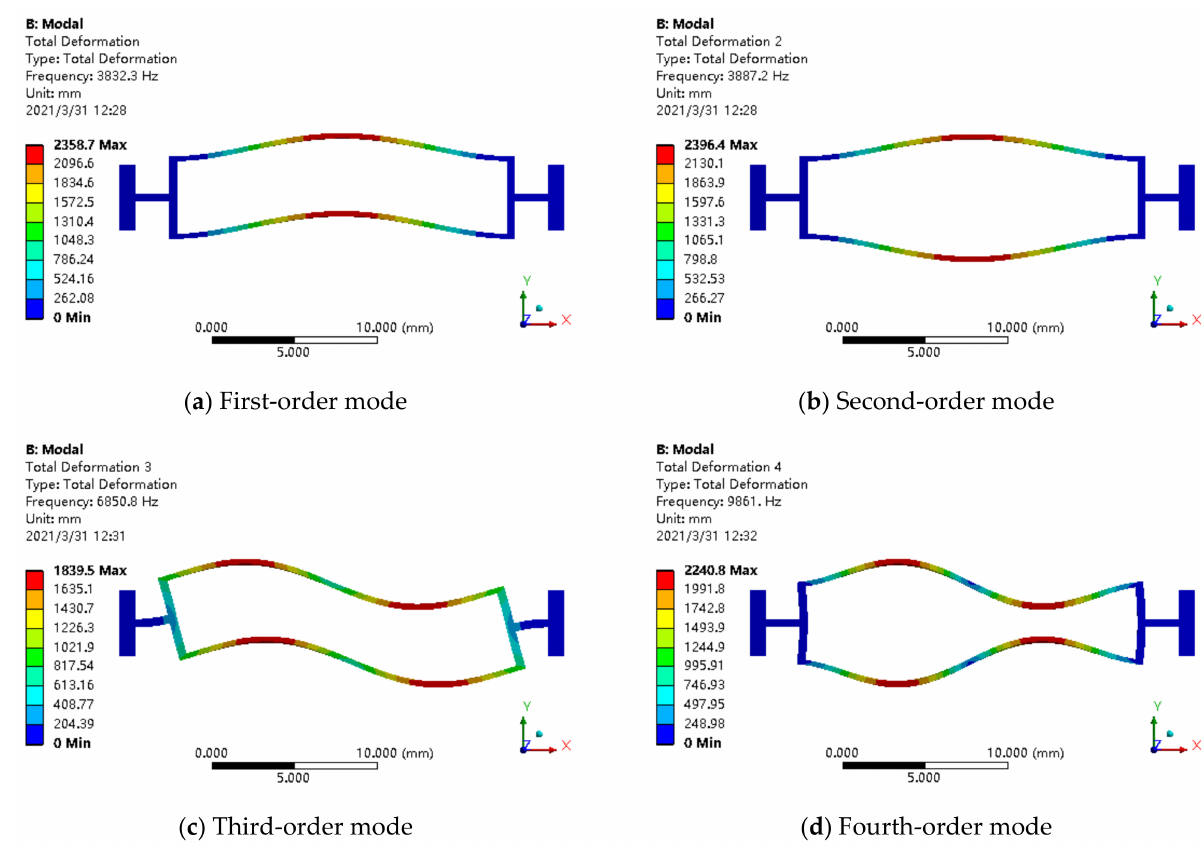
Figure 12. Beam root 1: ( a ) first-order mode; ( b ) second-order mode; ( c ) third-order mode; ( d ) fourth-order mode.